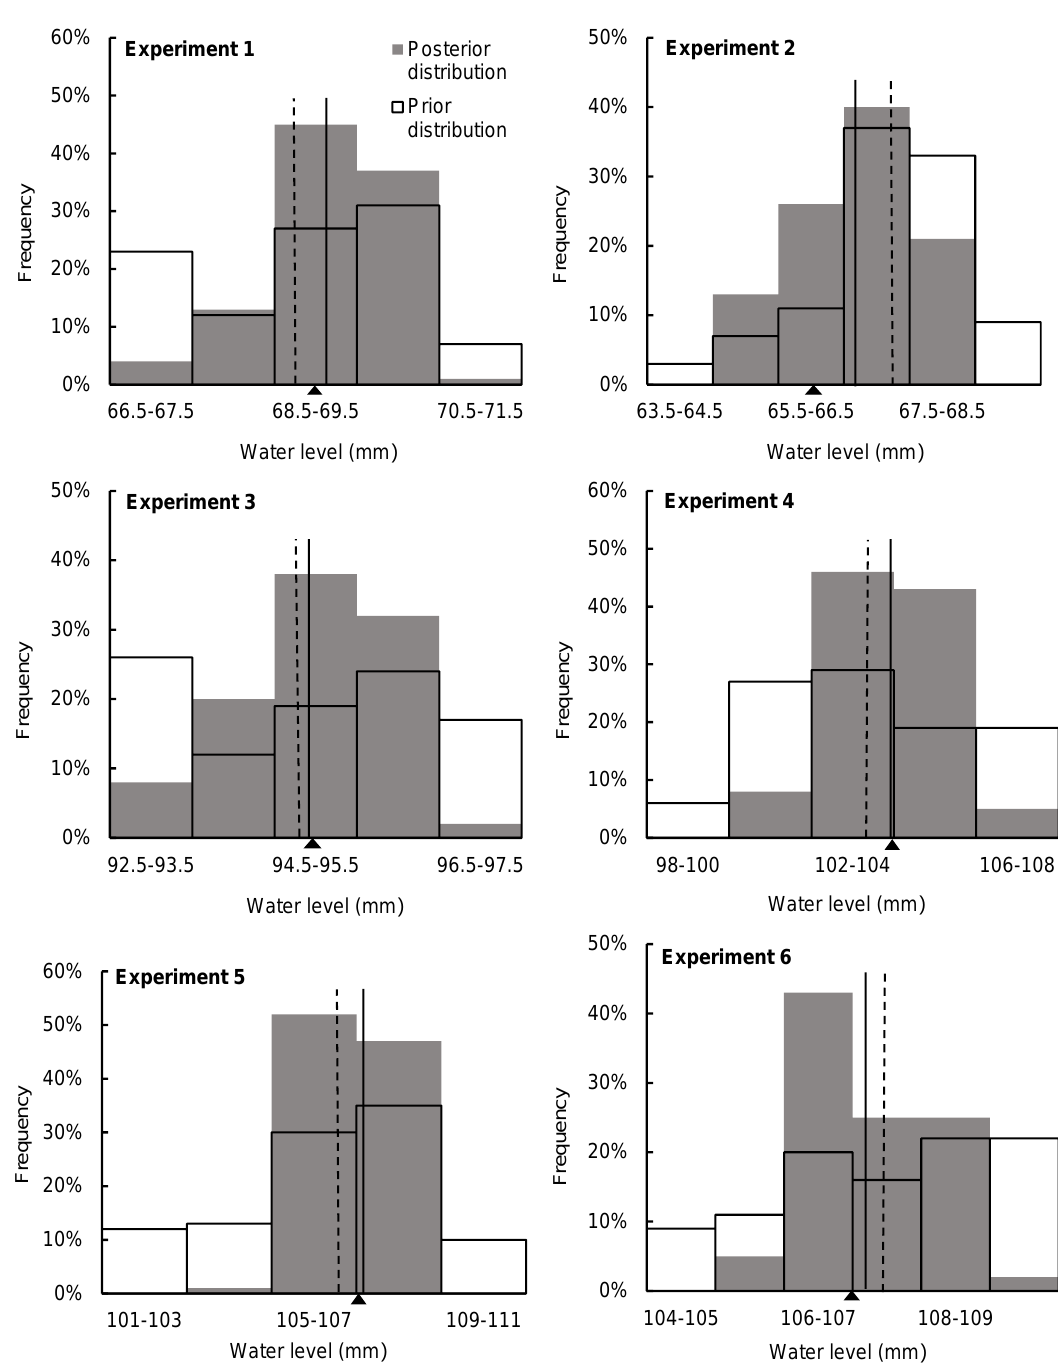
Figure 5. Histograms of prior (gray) and posterior (colorless) distributions of water levels in different experiments. The observed value is marked with a black triangle. The black dotted line indicates the mean value of the prior distribution of particles and the black solid line indicates the mean value of the posterior distribution of